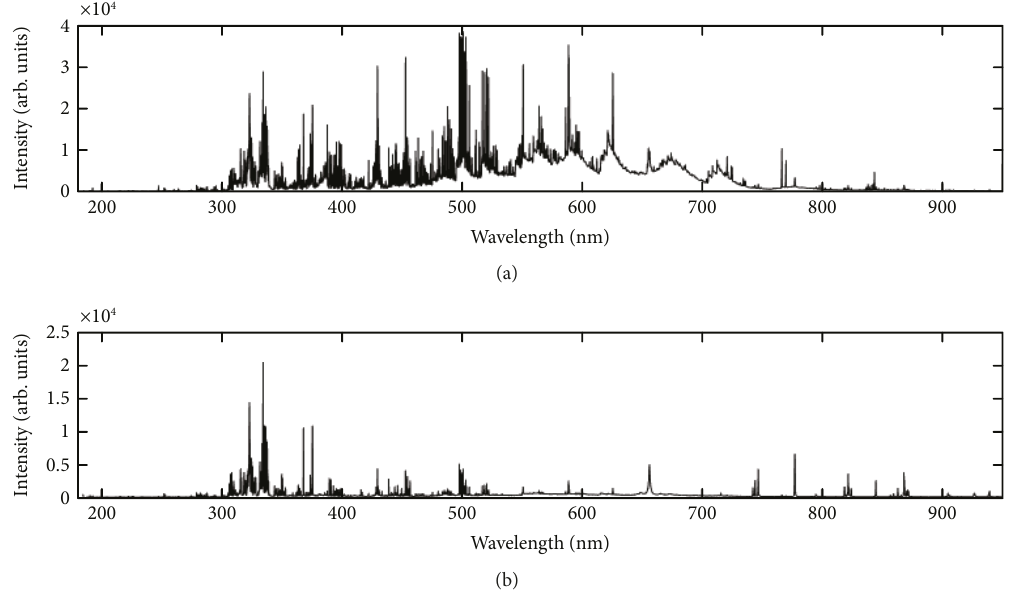
Figure 4: Average spectra acquired from 100 shots on the TD (a) and S (b) samples. Each shot was on a fresh surface which had not previously been sampled.